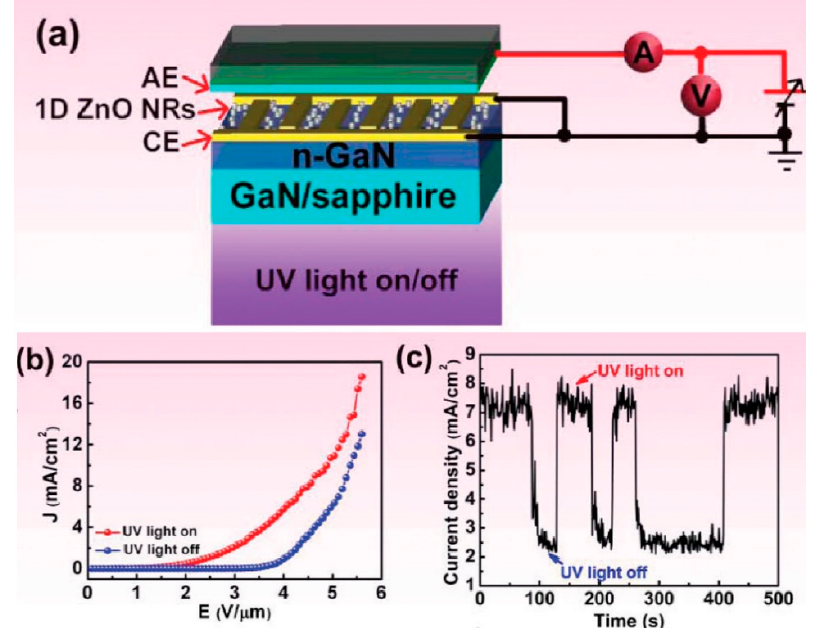
Figure 38. Schematic diagram ( a ), field-emission J-E characteristics ( b ) and time-resolved emission current density ( c ) of a ZnO nanorods/n-GaN photodector. Reproduced from [113], with the permission of RSC Pub, 2019.